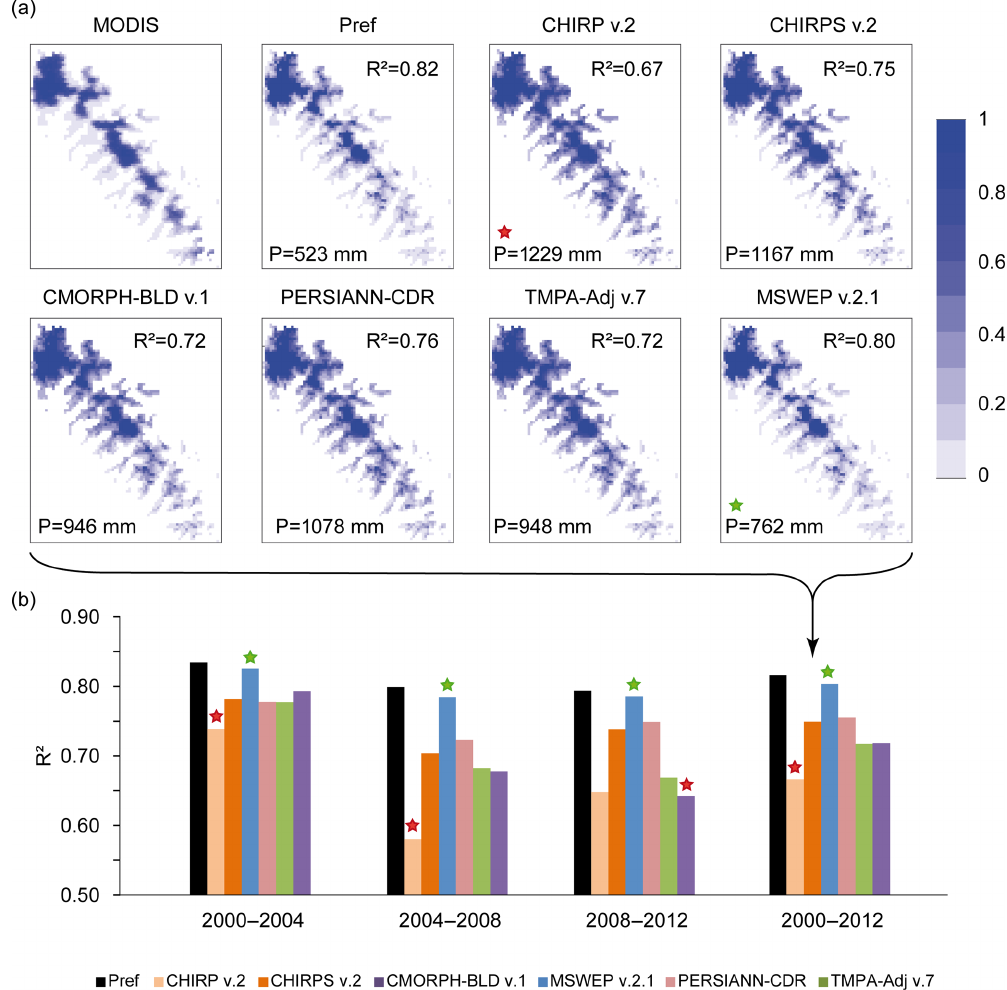
Figure 8. Observed (gap-filled MODIS snow products) versus simulated snow cover duration (SCD) using P ref and SPPs as input data in the snow model: (a) maps of snow cover duration for 2000–2012; (b) efficiency ( R 2 scores) of simulated SCD versus MODIS SCD for the different calibration periods. SCDs are expressed as the percentage of days over the simulation period. R 2 values stand for the grid-cell-to- grid-cell correlation between the observed and simulated SCD. Green and red stars highlight SPPs with the closest and further precipitation estimates to P ref over the subset